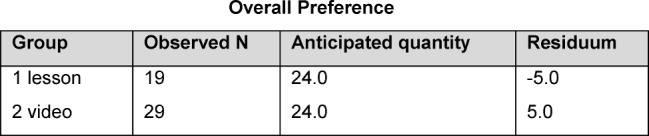
Overall preference